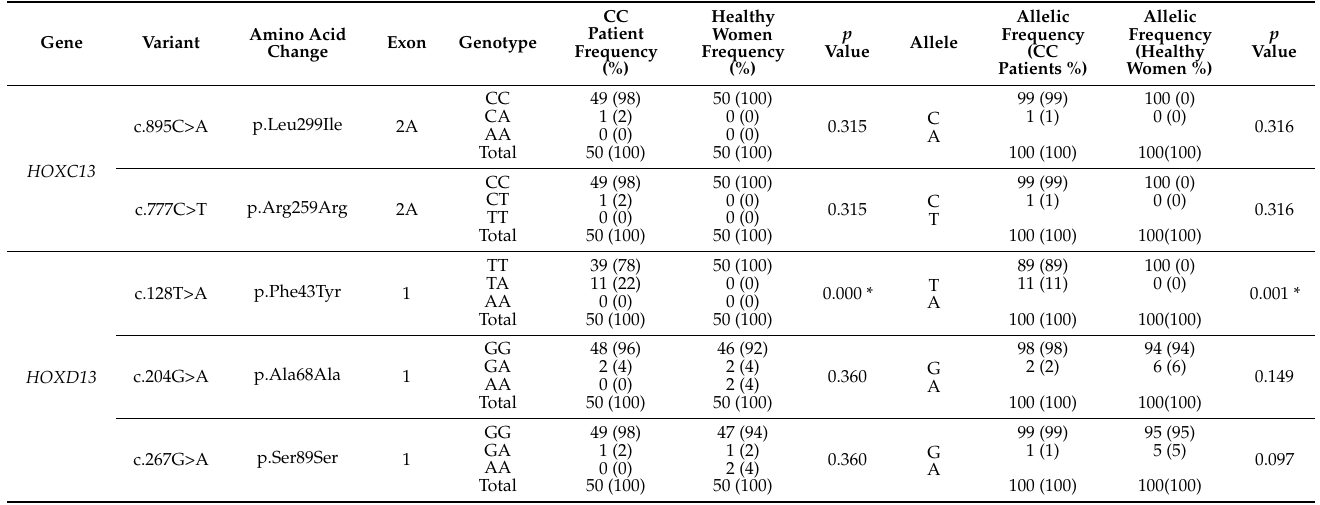
Table 2. Allelic and genotypic frequencies of HOXC13 and HOXD13 gene